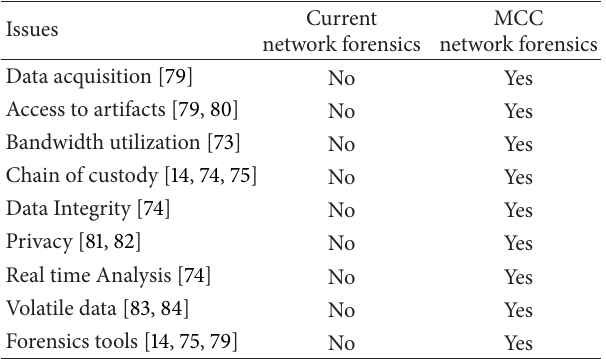
Table 3: Issues in current network forensics and MCC network